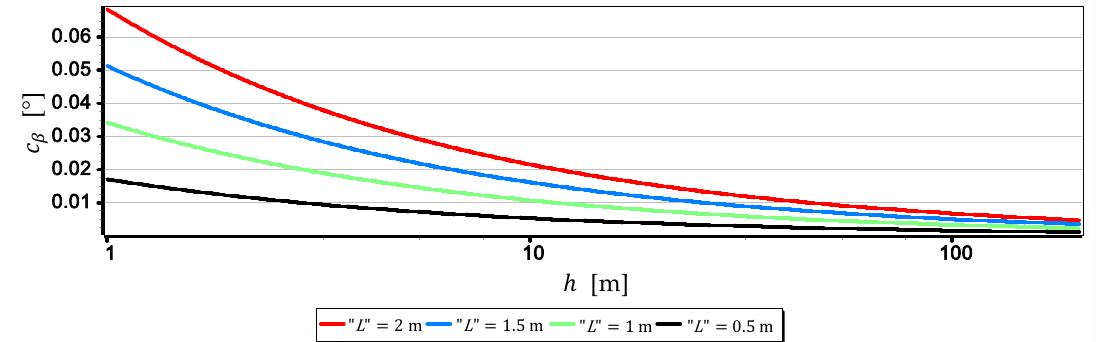
Figure 13. Measurement resolution of the horizon slop c β as a function of h for chosen wave heights “ L ” ( FOV H = 24.81 ◦ –DJI FC350).